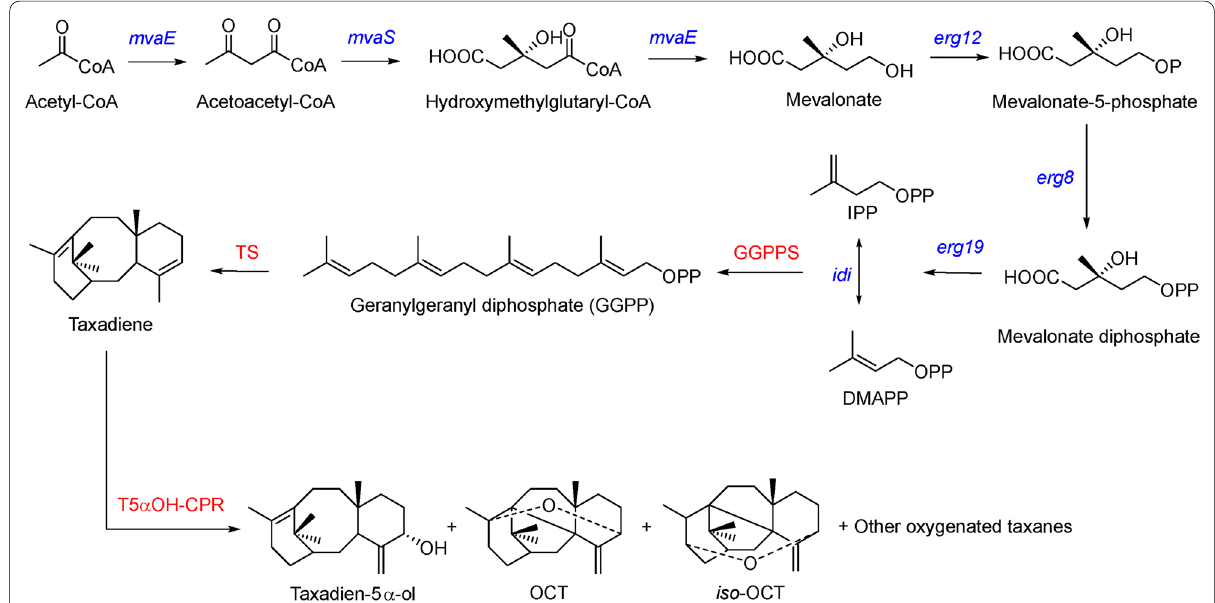
Fig. 3 Schematic diagram of the biosynthesis of oxygenated taxanes with a heterologous MVA pathway. mvaE : acetoacetyl‑CoA thiolase/HMG‑CoA reductase gene; mvaS : HMG‑CoA synthase gene; erg12 : mevalonate kinase; erg8 : phosphomevalonate kinase; e rg19 : mevalonate pyrophosphate decarboxylase; idi : IPP:DMAPP isomerase; GGPPS: geranylgeranyl pyrophosphate synthase; TS: taxadiene synthase; T5αOH‑CPR: the fusion protein of taxadiene‑5α‑hydroxylase and Taxus ‑derived cytochrome P450 reductase; OCT: 5(12)‑oxa‑3(11)‑cyclotaxane; iso ‑OCT: